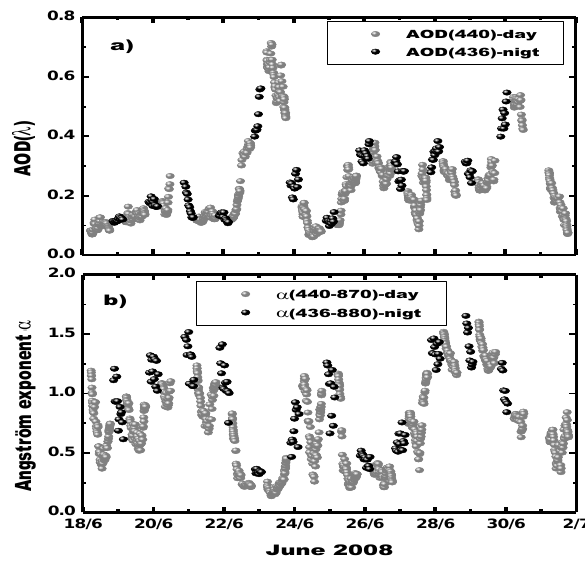
Fig. 9. Daytime and nighttime evolutions of columnar aerosol prop- erties for the period from 18 June to 2 July 2008. (a) Aerosol optical Figure 9: Daytime and nighttime evolutions of columnar aerosol properties for the depth (AOD). (b) Angstr¨om exponent α period from 18 June to 2 July 2008. a) Aerosol optical depth (AOD). b) Angström exponent α.